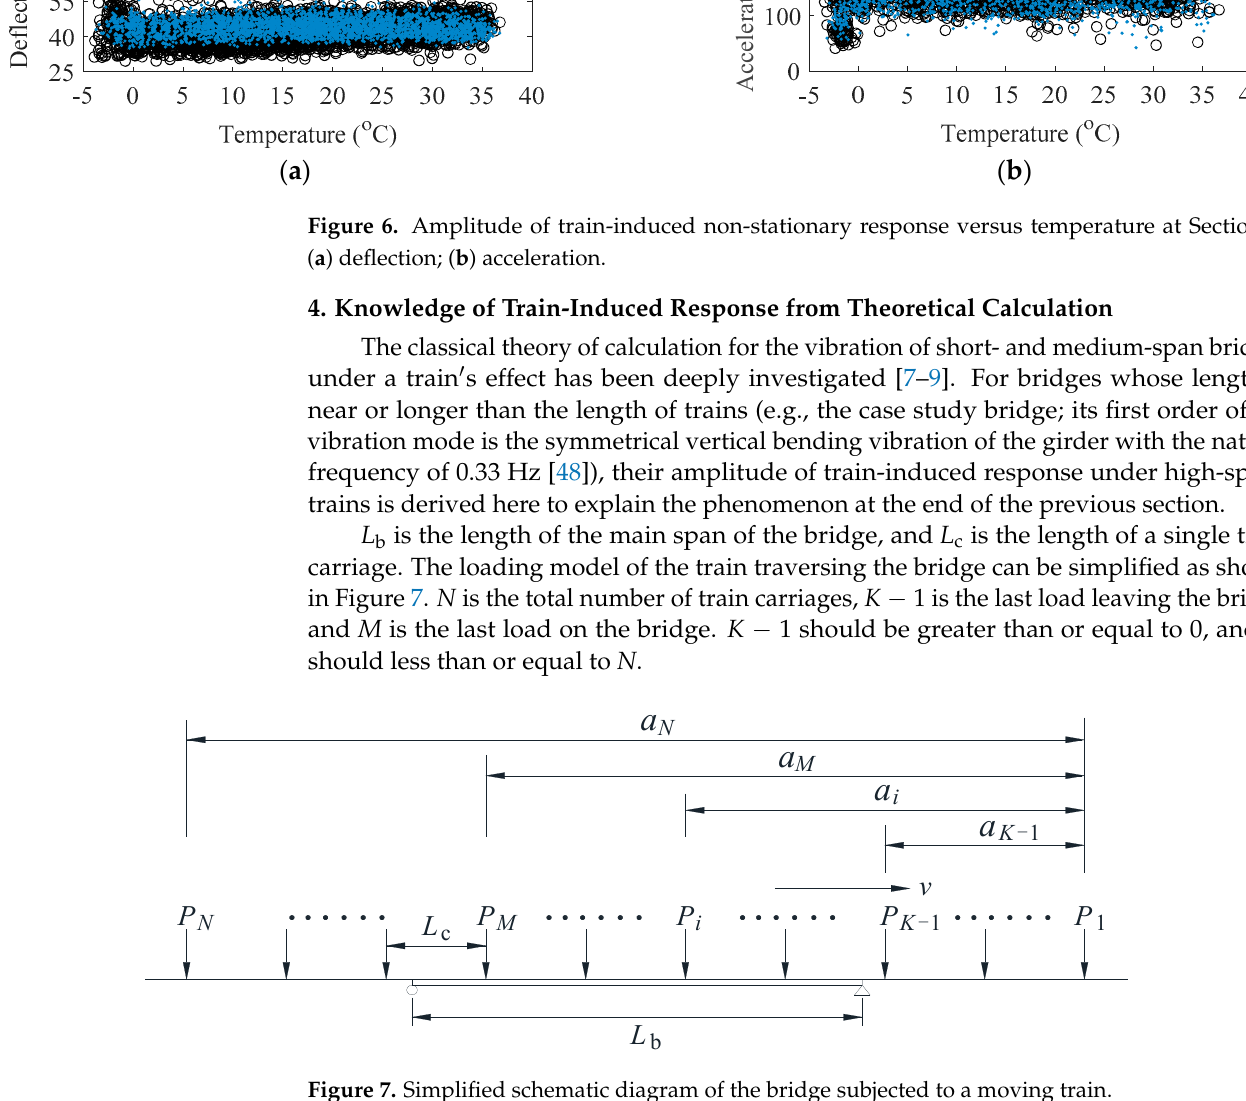
Figure 7. Simplified schematic diagram of the bridge subjected to a moving train.